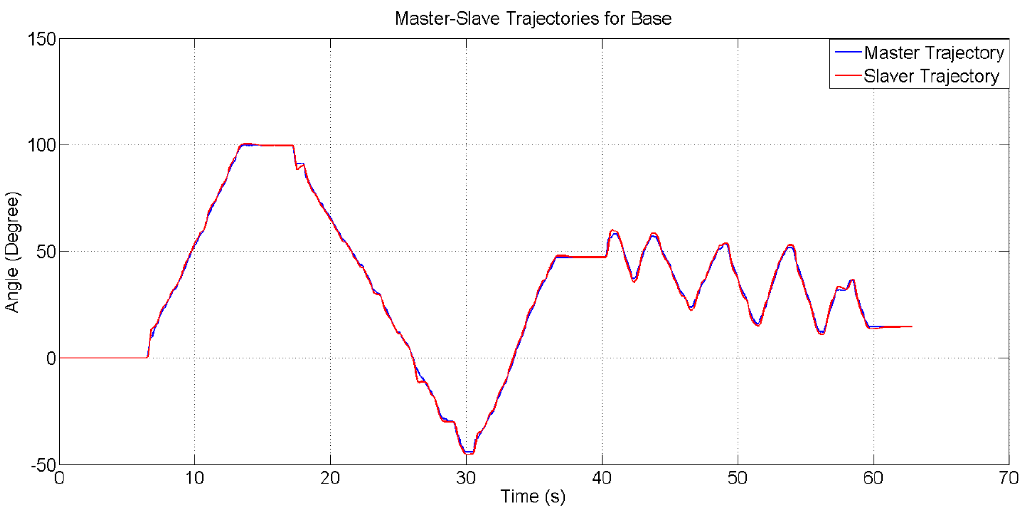
Figure 21. Master–slave trajectories for base.